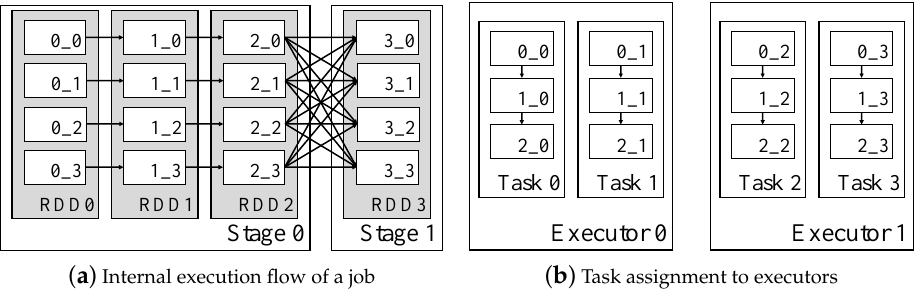
Figure 2. Internal representation of execution flow and task execution for blocks in Spark: x_y in blocks denotes dataset id ( x ) and partition id ( y